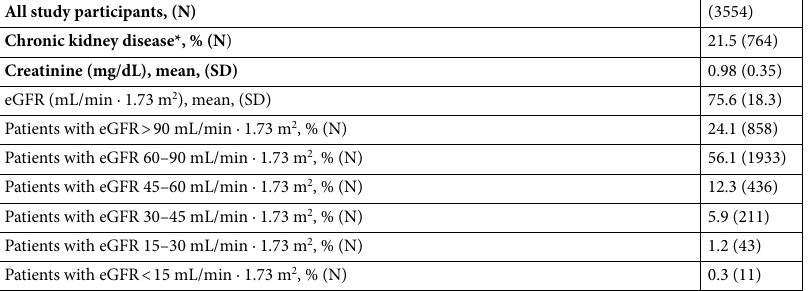
Table 2. Kidney function in the study participants. Abbreviations : eGFR, estimated glomerular filtration rate. *Chronic kidney disease was defined as the presence of kidney damage or an estimated glomerular filtration rate (eGFR) lower than 60 ml/min/1.73 m 2 , persisting for three months or more.